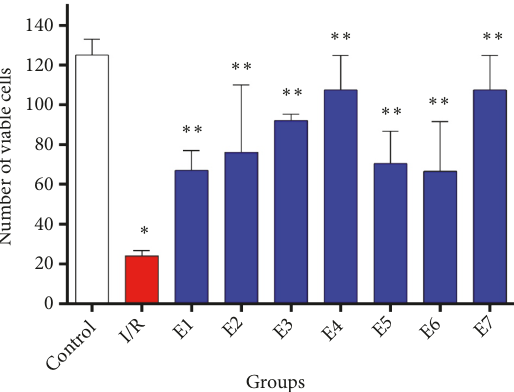
Figure 2: The quantitive analysis of Nissl staining indicated that, in I/R group, the number of viable cells significantly decreased in the comparison control group. Also, received FK506 ameliorated this reduction in all experimental groups. In addition, number of survived neurons in E7 is higher than those of other groups, indicating the best treatment dose. Data are presented as mean ± SD.